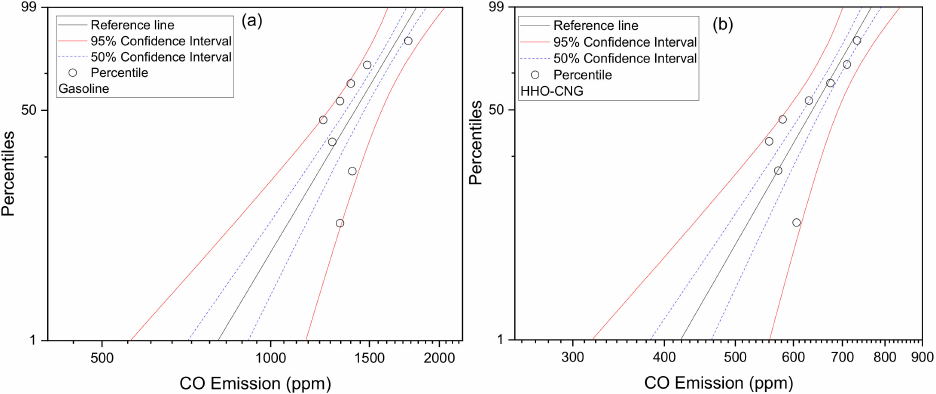
Figure 5. ( a ) CO Weibull distributions for various CIs using gasoline and ( b ) CO Weibull distributions for various CIs using